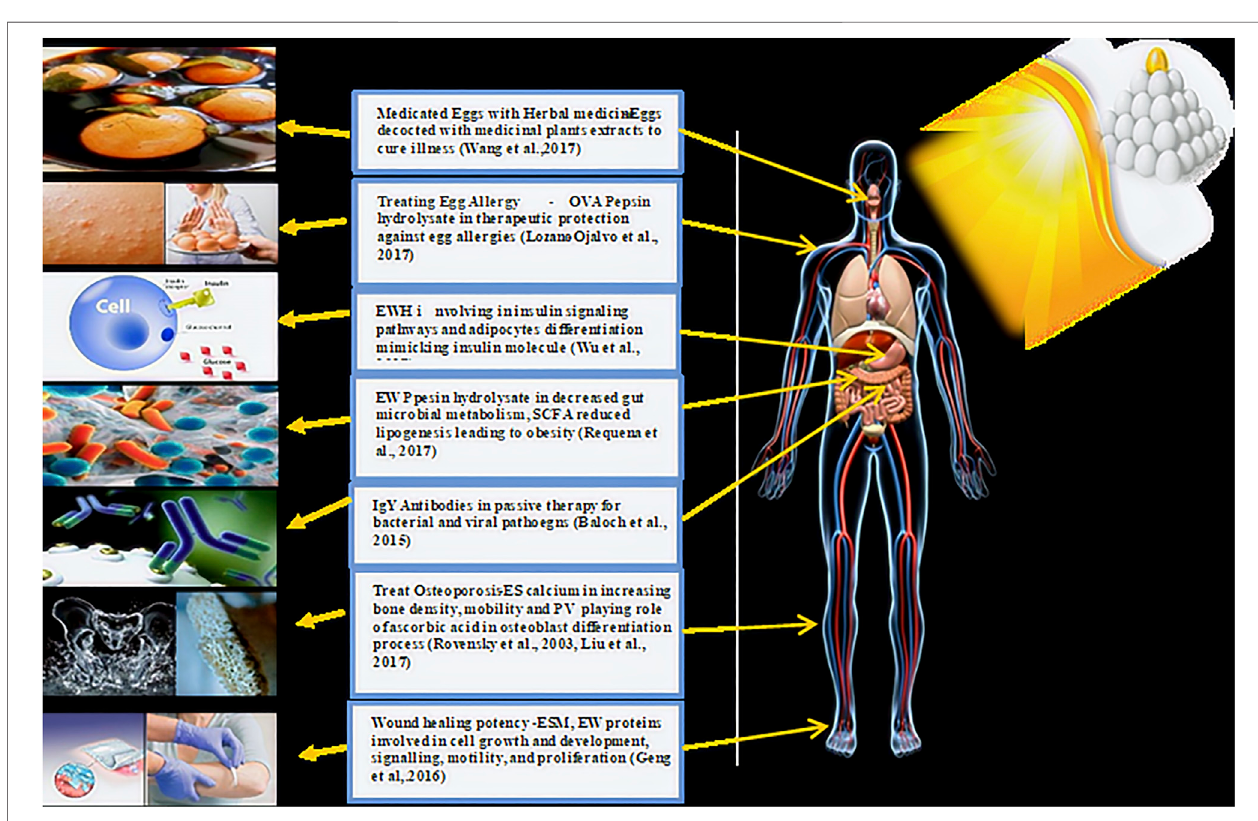
FIGURE 3 | Role of eggs and its bioactive components in human